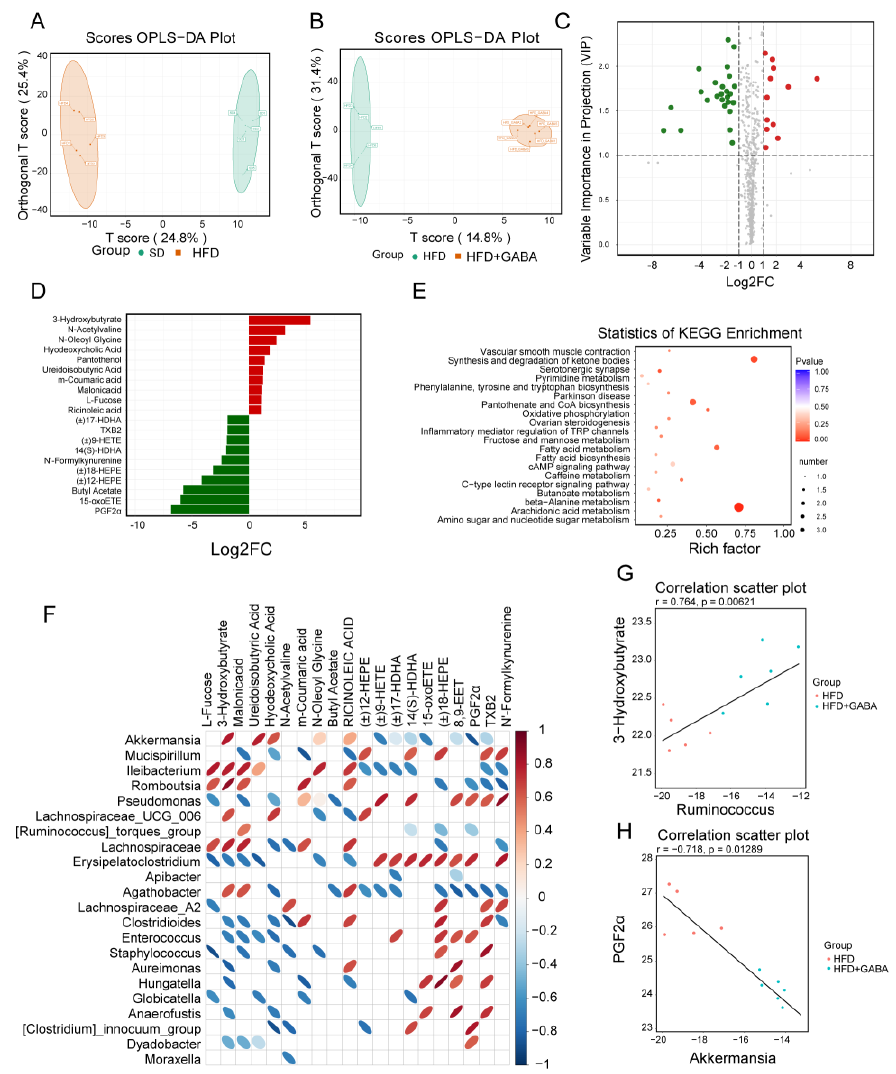
Figure 7. Bacterial metabolites affect the regulation of GABA on fat beige. ( A , B ) OPLS-DA score plot of metabolite profiles. ( C ) Volcano plot of metabolites between the HFD and HFD+GABA groups. The green dots represent downregulated differentially expressed metabolites, the red dots represent upregulated differentially expressed metabolites, and the gray ones represent detected but not significant metabolites. ( D ) Histograms of LDA scores identifying the taxa differentially represented between HFD and HFD+GABA groups (LDA score > 2). ( E ) Statistics of KEGG enrichment and classification. ( F ) Correlation diagram between the top 20 differential metabolites and intestinal microbes in the HFD and HFD+GABA groups. Each row represents a type of microorganism, and each column represents a metabolite. The red ellipse indicates a positive correlation, and the blue ellipse indicates a negative correlation. The greater the absolute value of the correlation, the thinner the ellipse. A blank grid indicates a significant p -value > 0.05. ( G , H ) Spearman correlation analysis between 3-hydroxybutyrate and Ruminococcus ( G ) and PGF2 α and Akkermansia ( H ). OPLS-DA, orthogonal partial least squares discriminant analysis.